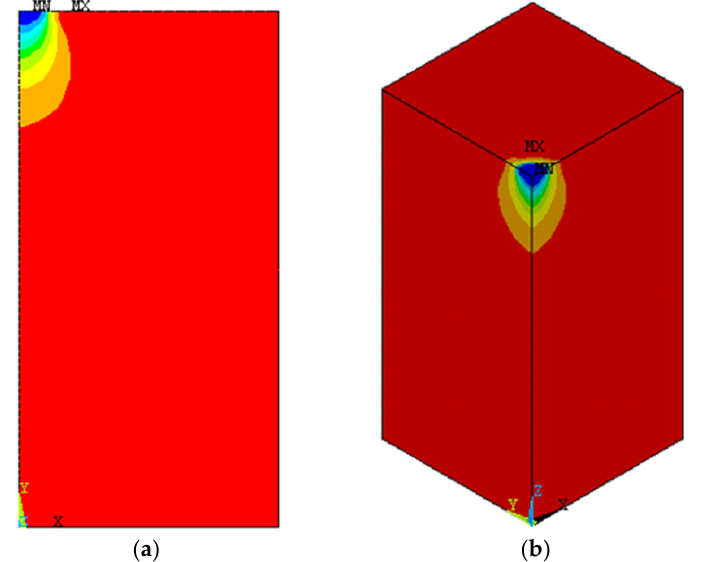
Figure 20. Vertical stresses beneath the 85 mm circular footing: ( a ) 2DM; ( b ) 3DM.